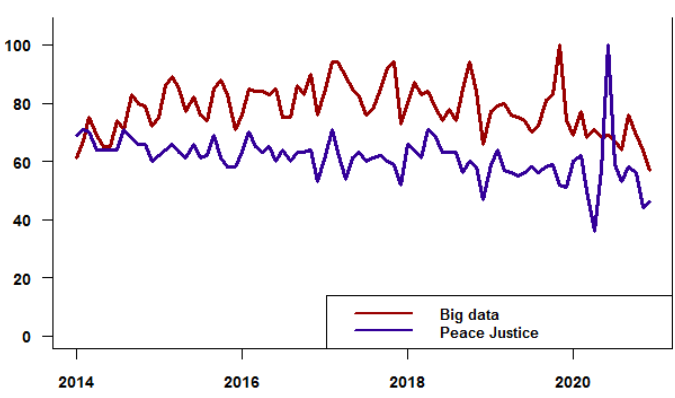
Figure 17. Big Data and SDG 16 global Google trends since